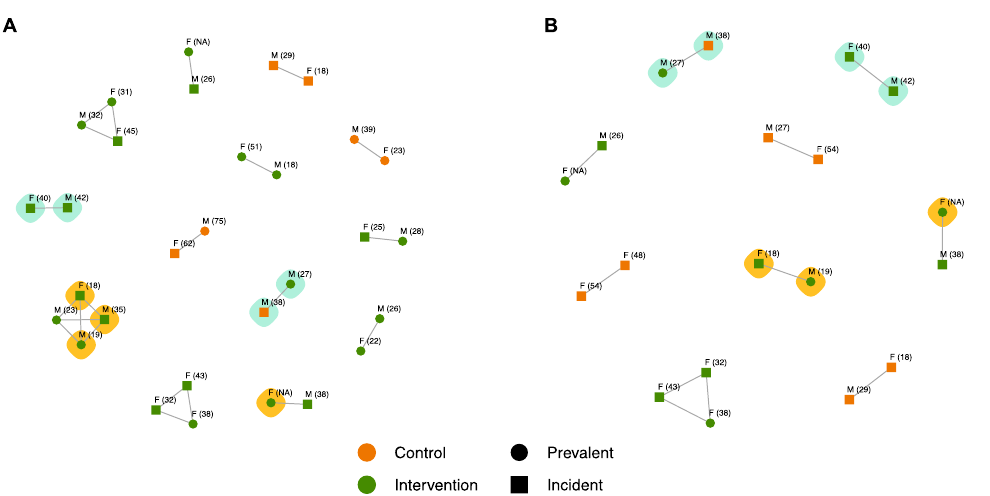
Figure 3. ( A ) SEARCH sequenced participants in <1.5% pairwise genetic distance (GD) clusters ( n = 30 sequences) and ( B ) participants in SEARCH-incident, phylodynamic clusters ( n = 19 sequences). Nodes representing participants from control communities are in orange, intervention communities are in green; circles represent prevalent infections, squares incident infections; nodes are labelled with the gender (M = male, F = female) and age (years, in brackets) for each participant; turquoise-highlighted clusters are inferred inter-community transmissions, gold-highlighted sequences are NNRTI resistant. Table 5. Characteristics of SEARCH <1.5% pairwise genetic distance (GD) clusters ( n = 13) and of phylodynamic clusters arising after the start of the SEARCH trial ( n = 9).